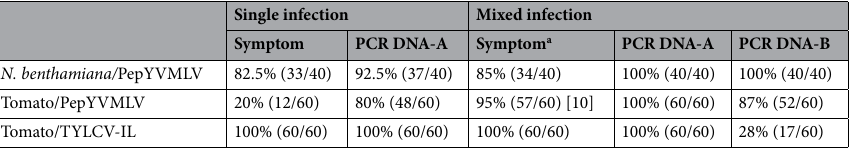
of ten plants. At 15, 22 and 29 dpi, the DNA-A molecules accumulated more in mixed infections than in single infections (264, 25 and 35-fold, respectively; p < 0.001). For all real-time PCR assays, positive linear relationships were found between the normalized copy numbers of PepYVMLV DNA-A and DNA-B (Fig. 3b). Similar results were obtained at 32 dpi in an independent experiment (data not shown), using TaqMan real-time PCR assays. Higher transmission rate of PepYVMLV DNA‑A in association with DNA‑B. Two transmission experiments were performed independently using synchronous adult female individuals of the cryptic species Middle East-Asia Minor 1 (MEAM1) of B. tabaci, fed on tomato plants agroinoculated with PepYVMLV DNA-A